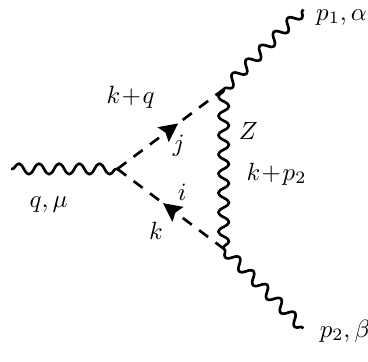
Figure 3 . Contribution to the Z 3 vertex (cid:0)